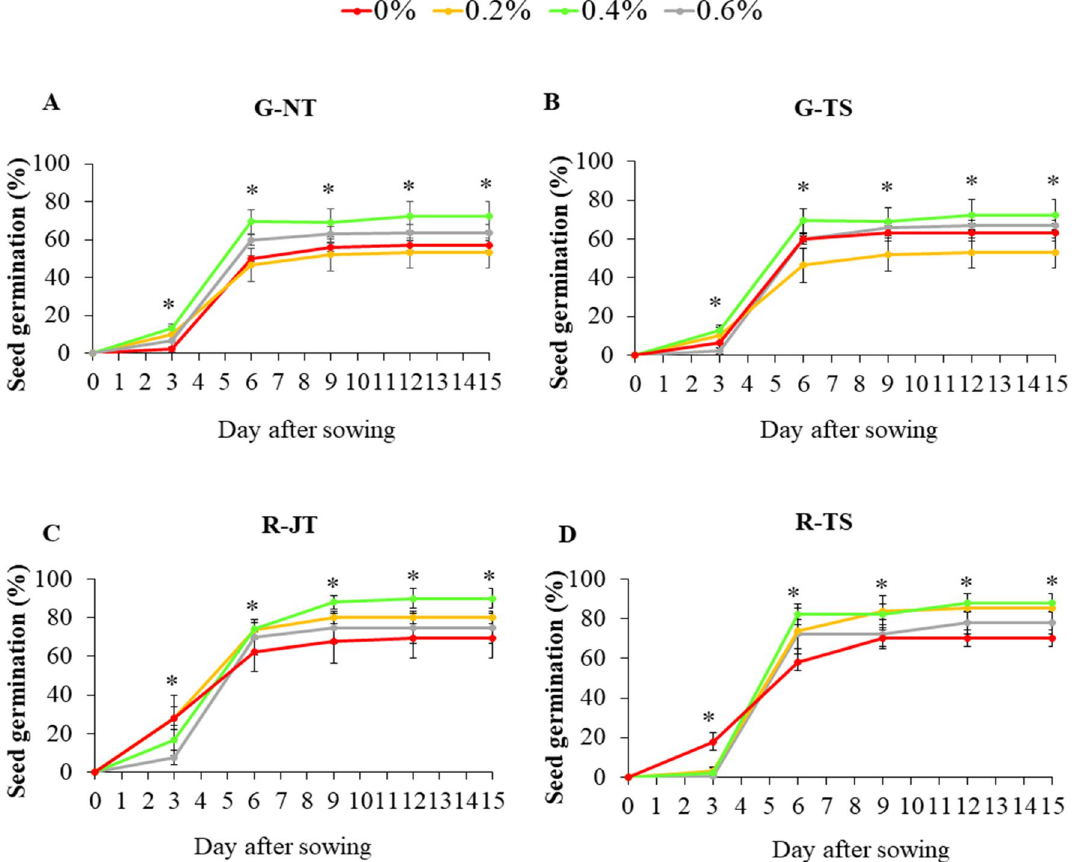
Figure 2. Seed germination percentage (%) after sowing in 0%, 0.2%, 0.4% and 0.6% of KNO 3 concentration of four holy basil varieties from three companies; G-NT ( A ), G-TS ( B ), R-JT ( C ) and R-TS ( D ). Bars represent standard error of four biological replicates. The measurement was performed with fifty seeds in a replication. ANOVA was performed followed by mean comparison with